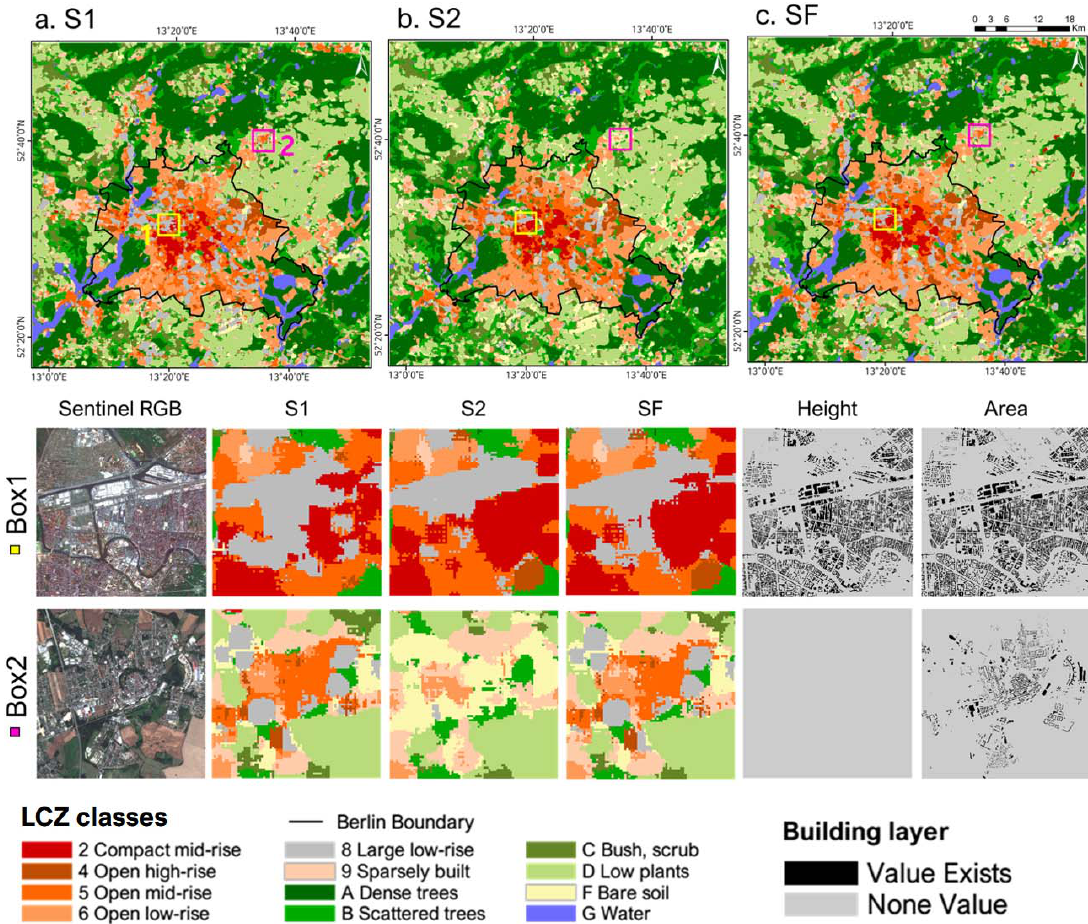
Figure 7. LCZ maps with the best classification models of three schemes (S1, S2, and SF) for Berlin. Building height and area layers from BH2012 and OSM are also included. The enlarged results of each scheme and building components for two subset areas (Box 1 and Box 2) are presented. Box 1 was full of building information, while Box 2 had many missing values in building information.